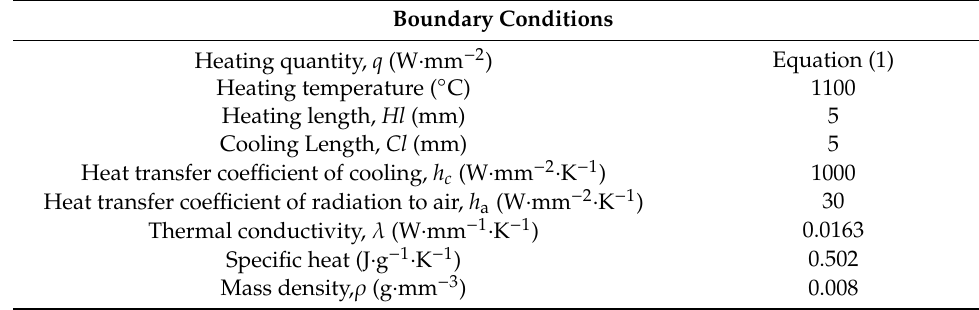
Table 1. Material model and Boundary conditions of SUS 304 used in Finite Element Model (FEM).